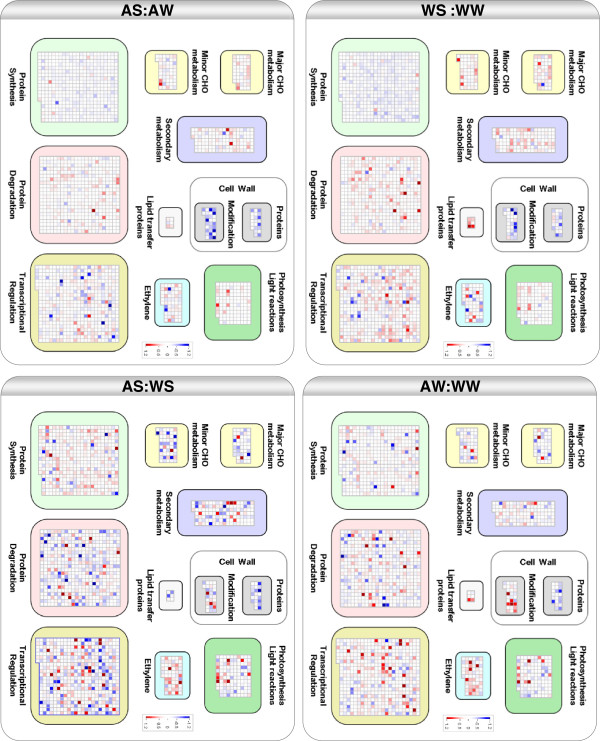
Summary of biological pathways affected at the transcriptional level by Alethea and salinity. Custom MapMan diagram showing changes in gene expression in key biological processes significantly altered by salt and Alethea treatments. The figure is based on gene expression ratio data for relevant pair-wise treatment comparisons. Treatment groups are identified using two-letter abbreviations, where the first letter indicates the pre-treatment (W; water, A; Alethea) and the second letter the main treatment (W; water, S; salt). Squares show changes in expression of individual genes within a pathway via a heat map scheme, with red indicating up-regulation and blue, down-regulation of expression. Heat map scales to the right of each image indicate log2 fold-change expression values.